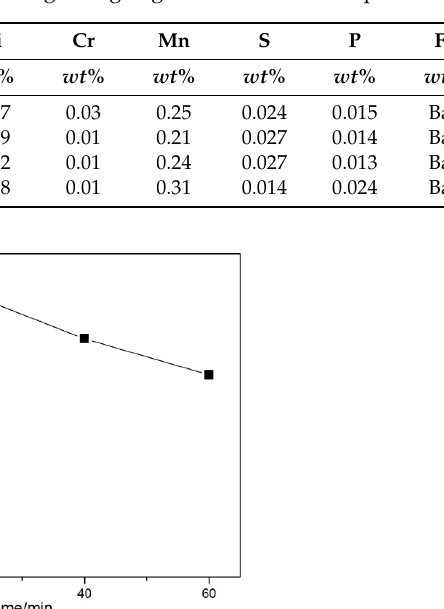
Table 1. Chemical compositions of DI after injecting nitrogen gas for di ff erent time periods.